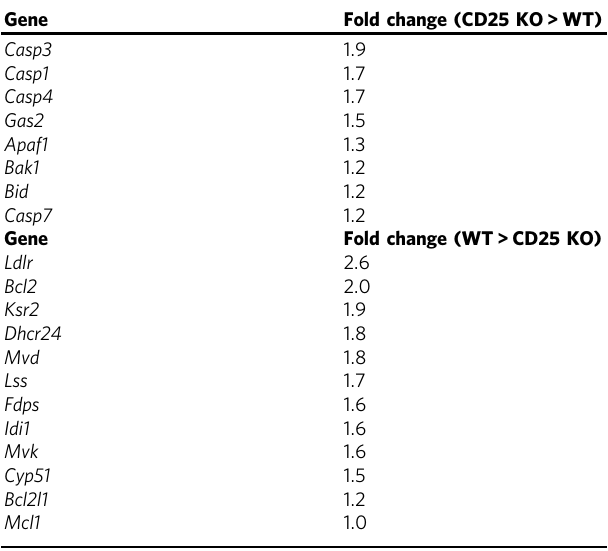
Table 1 CD25-de fi cient Tregs show differential mRNA expression related to apoptosis and